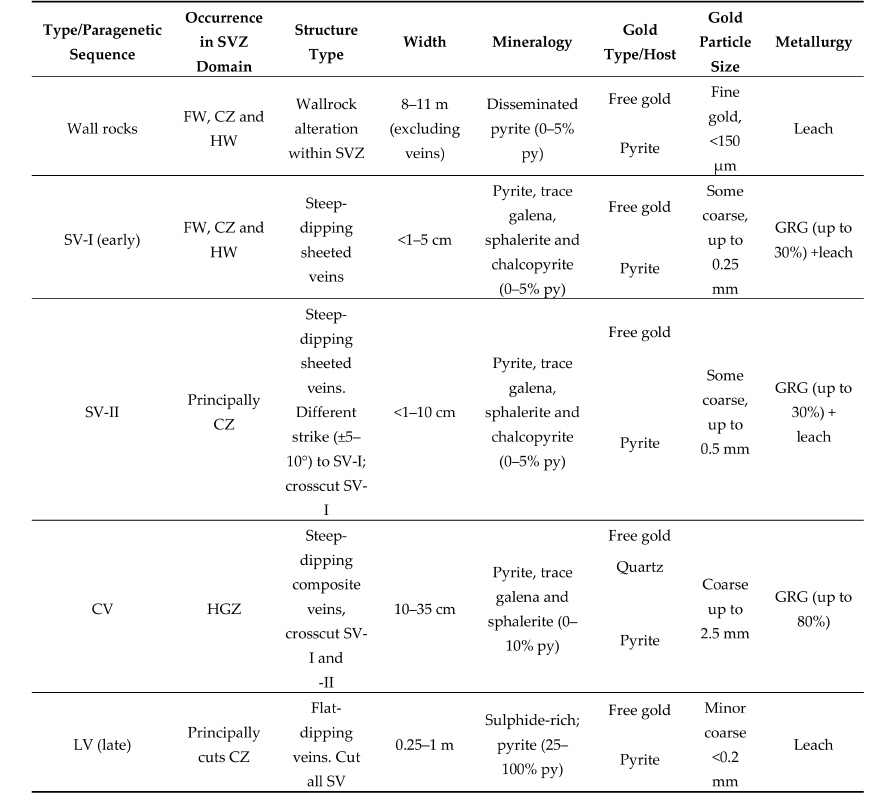
Table 28. Vein paragenetic sequence within the SVZ and mineralogical and metallurgical